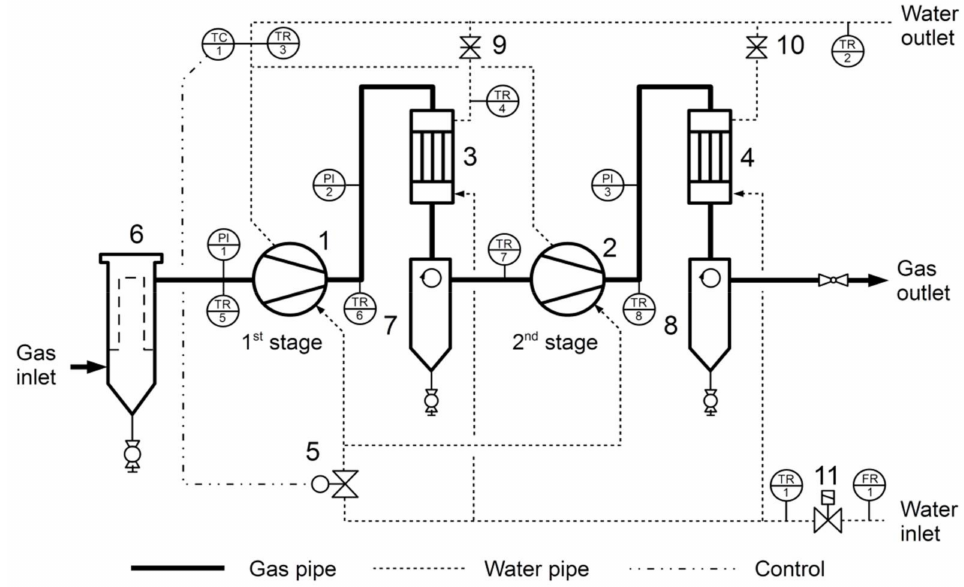
Figure 1. Compressor connection diagram including the description of the measuring and regulation technology (1—Stage 1 of the compressor, 2—Stage 2 of the compressor, 3—intercooler,